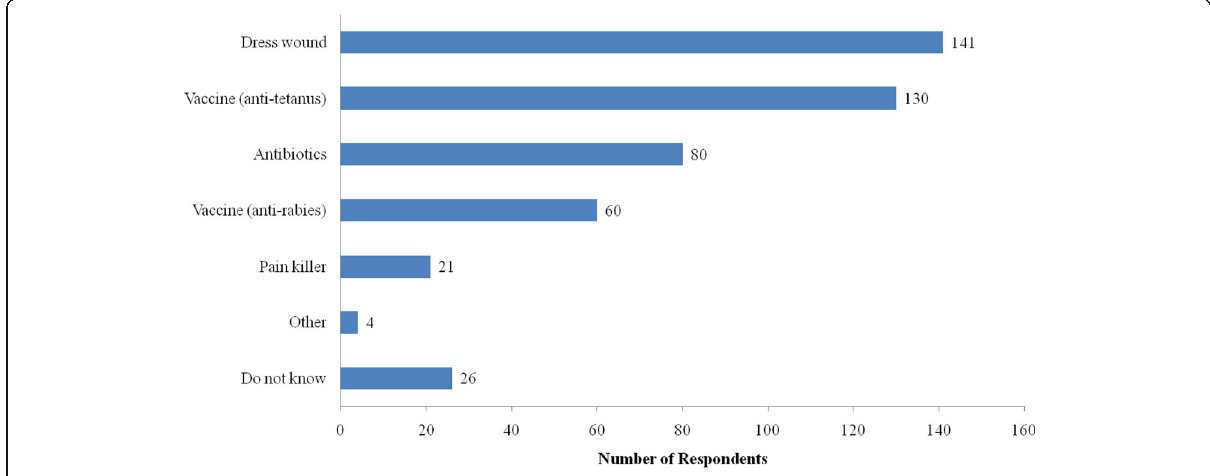
Fig. 5 Expected treatment by respondents after a dog bite ( n =